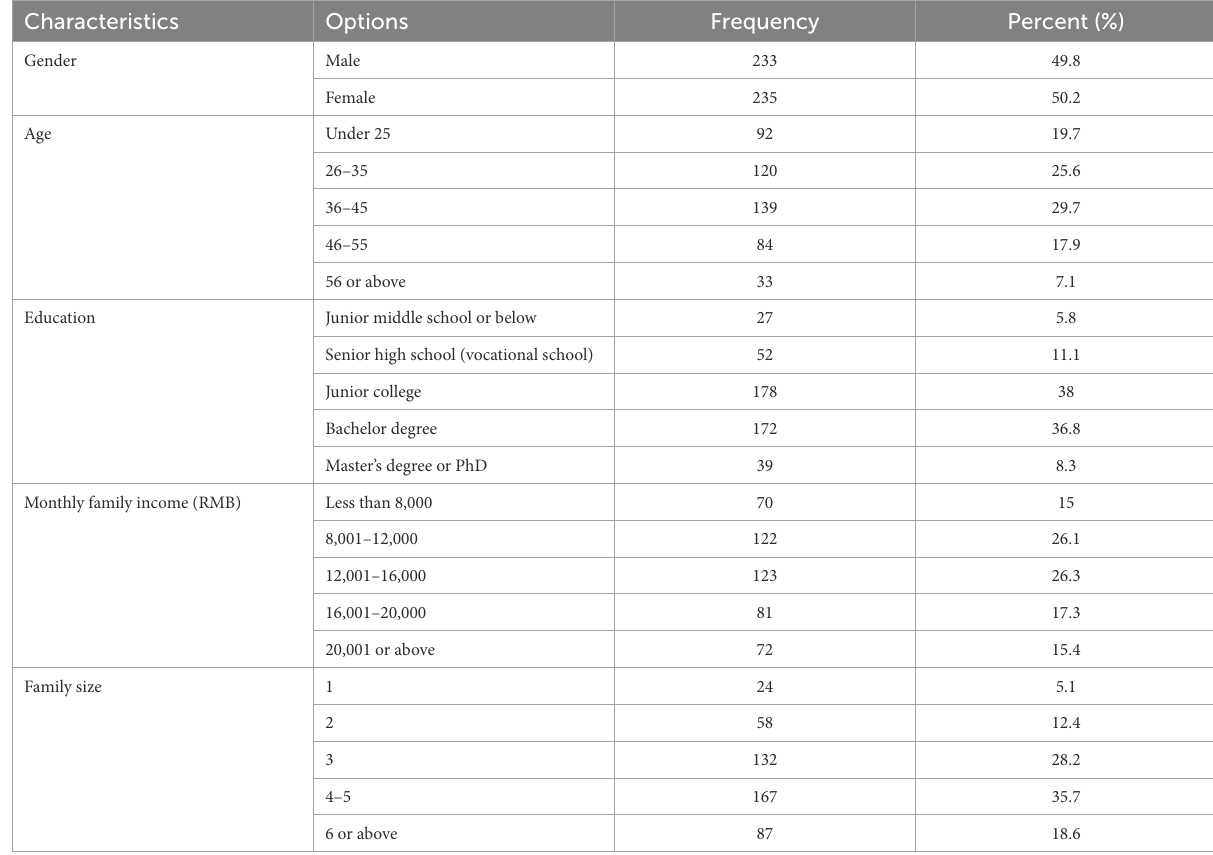
TABLE 1 Respondent profile ( N =